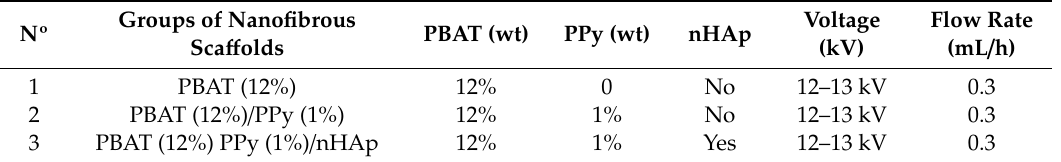
Table 1. Groups of nanofibrous sca ff olds, percentage of PBAT, PPy, presence of nHAp, voltage, and flow